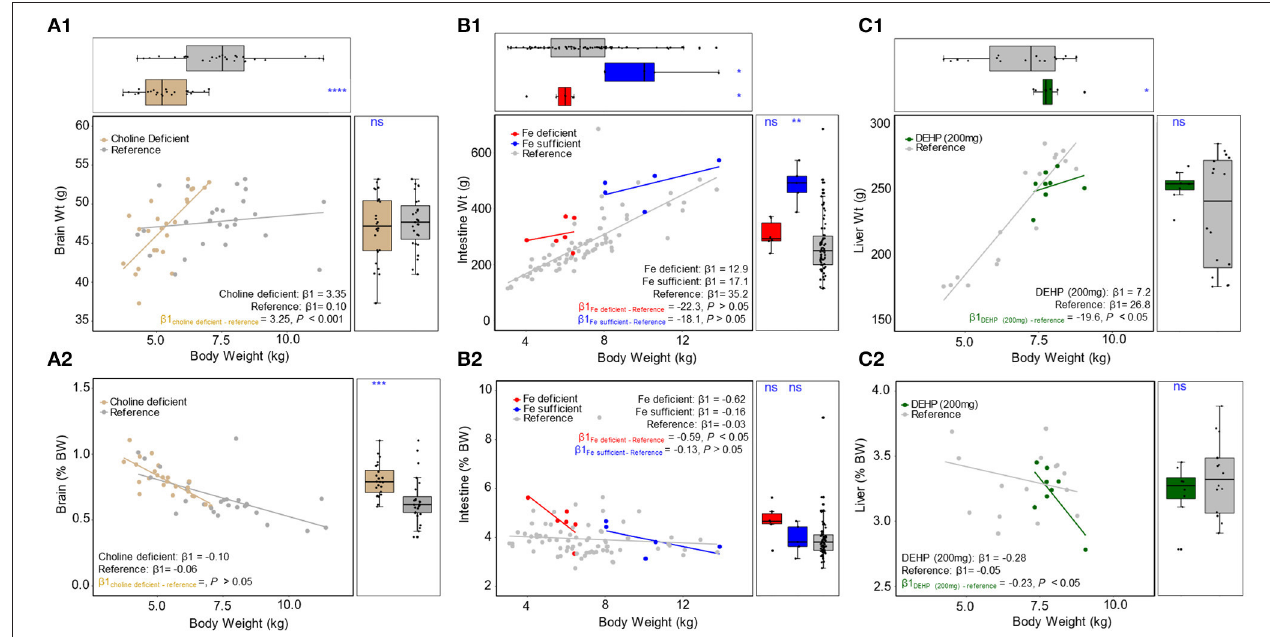
FIGURE 6 | Scatter plot with marginal boxplots of absolute (top) and relative (bottom) organ weights are plotted as a function of BW for (A1,2) brain, comparing choline deficient experimental pigs and typical reference pigs, (B1,2) intestine, comparing iron deficient, iron sufficient, and typical reference pigs, and (C1,2) liver, comparing DEHP (200mg) and typical reference pigs. ns p > 0.05, * p ≤ 0.05, ** p ≤ 0.01, *** p ≤ 0.001, **** p ≤